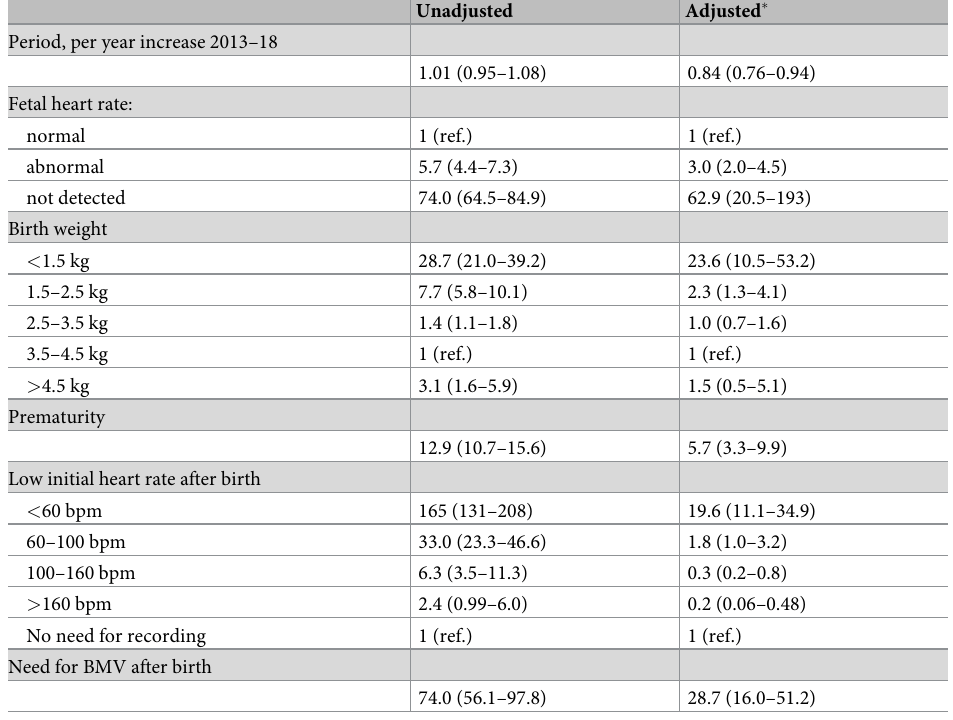
� adjustments for fetal heart rate, birth weight category, prematurity, low initial heart rate and need for BMV after birth. In perinatal mortality results the initial heart rate and presumed need for BMV were set to the lowest